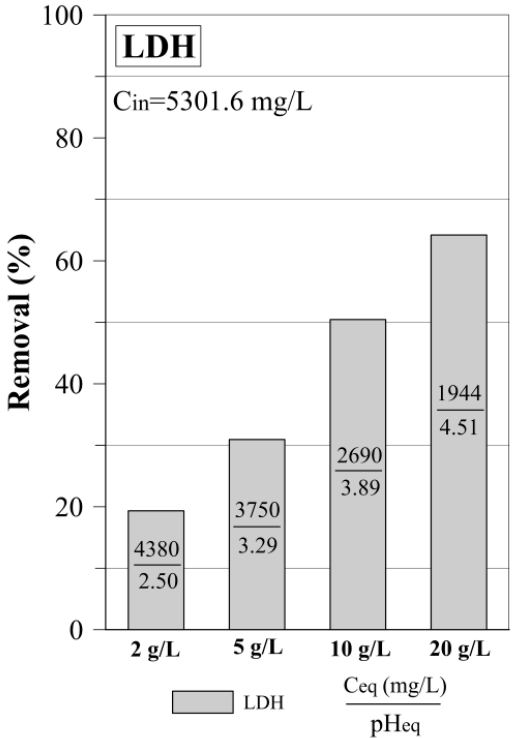
Figure 1. Sulfate removal by layered double hydroxide (LDH) in the function of dosage.